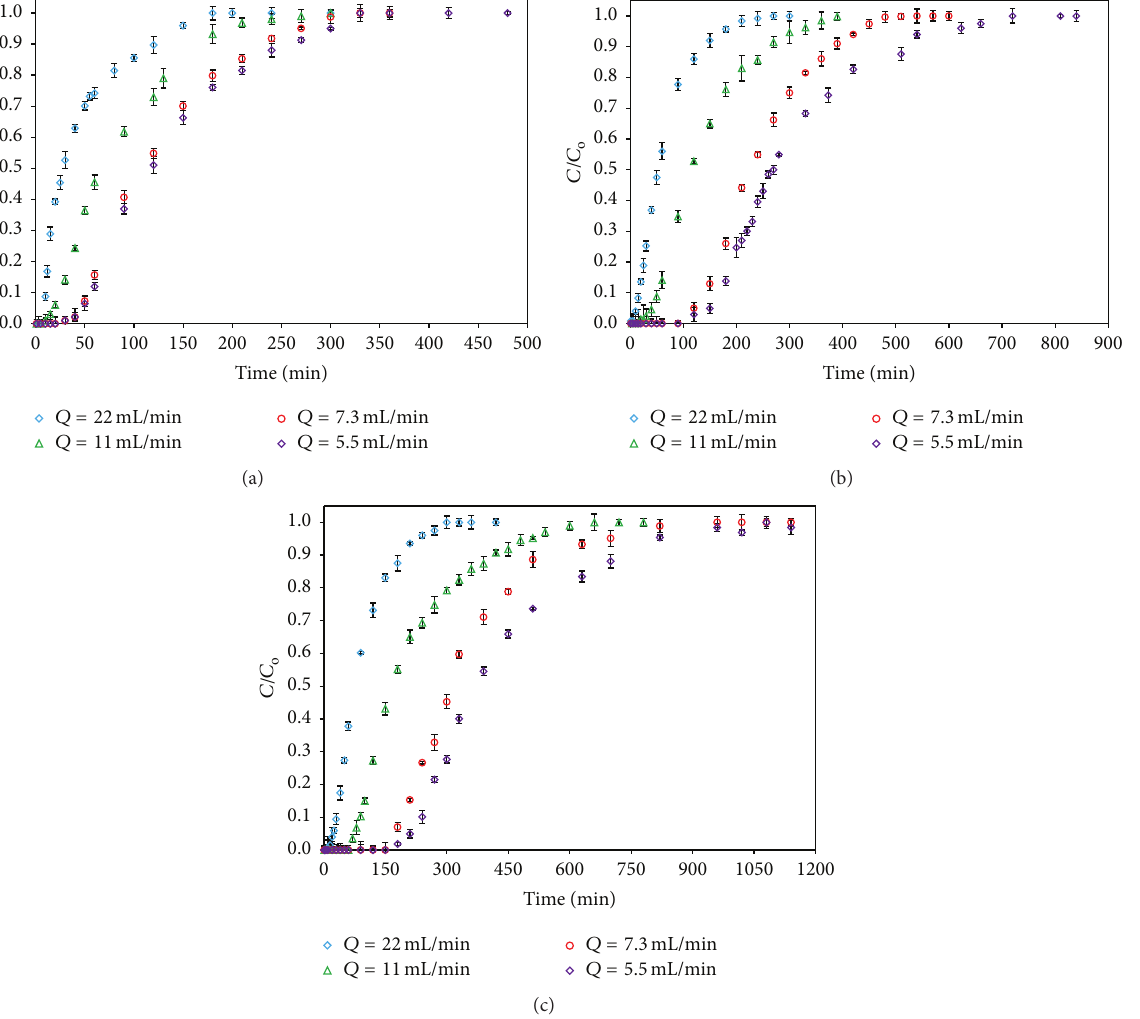
Figure 6: Effect of the flow rate on the breakthrough curves of (a) Cd 2+ , (b) Cu 2+ , and (c) Pb 2+ . Experimental conditions: 0.1mM initial metal concentration, pH 4.5, and 25 ∘